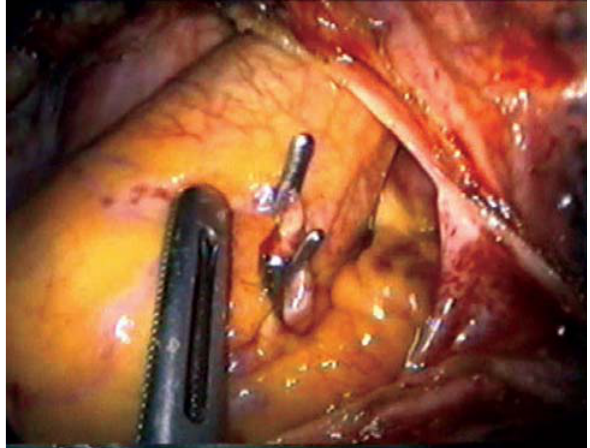
Fig.2 – Aspecto videoscópico da ligadura da fístula